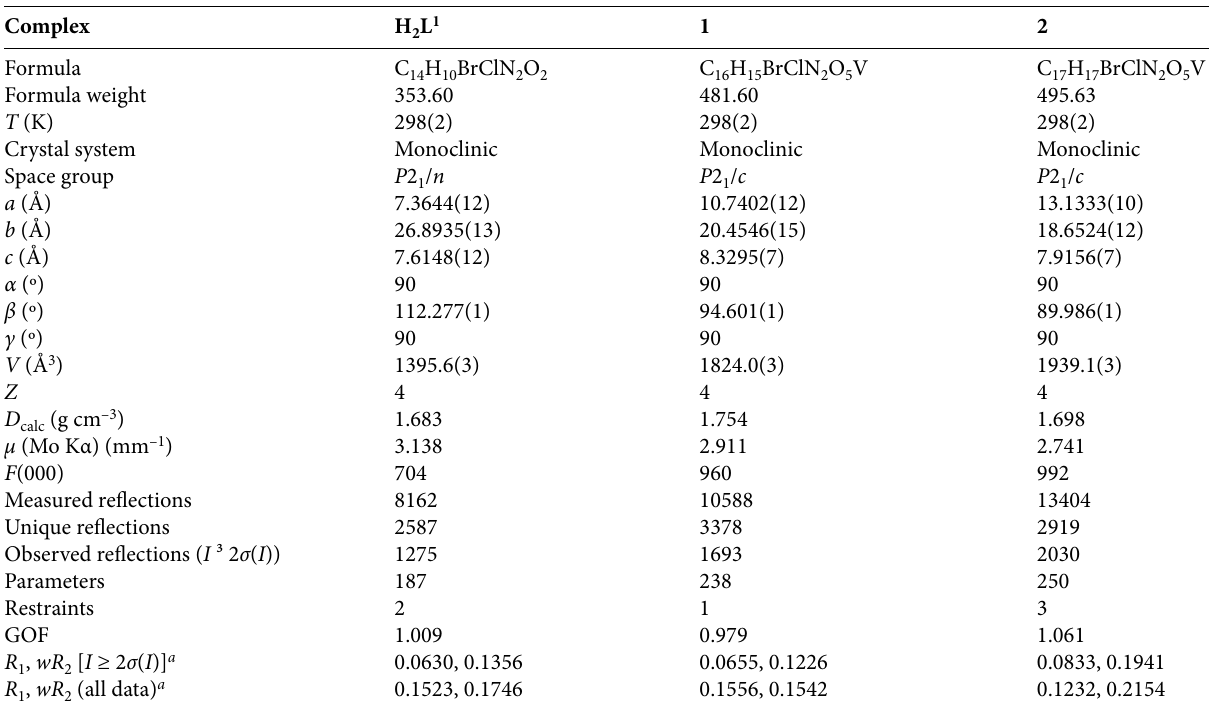
Table 1. Crystallographic and refinement data for the complexes